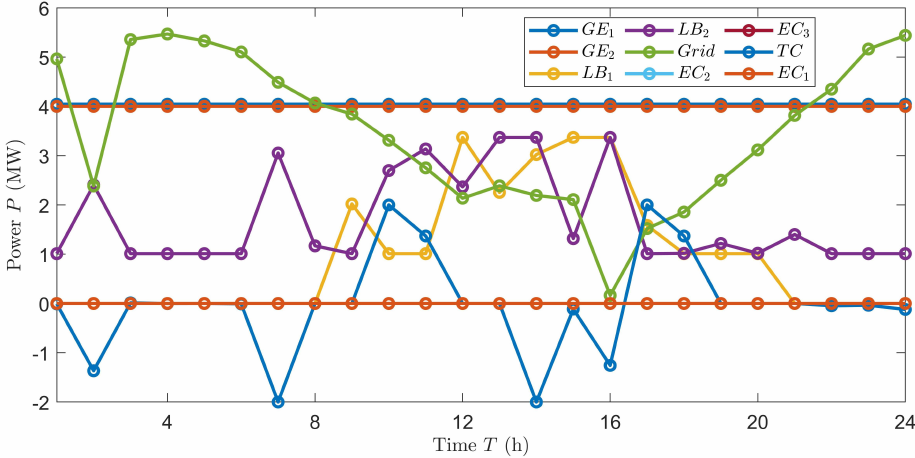
Figure 11. Equipment output (cooling season, determining heat by